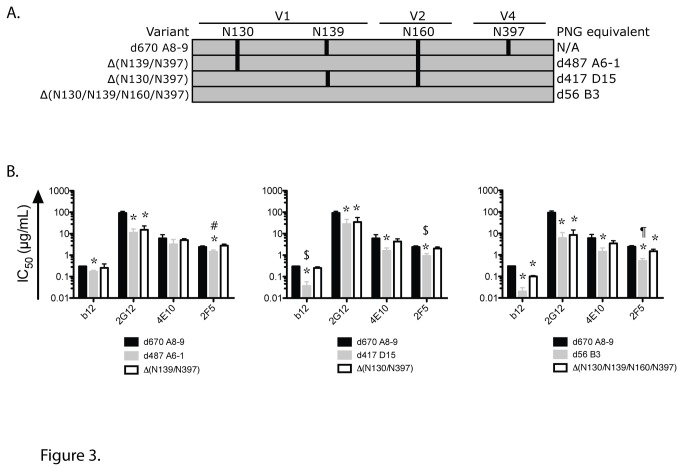
Specific PNGS affect heterologous neutralization.(A) Cartoon depicting PNGS profiles of A141 Env mutants. The mutants are indicated on the left and the corresponding PNG equivalent A141 clones are indicated on the right. Vertical bars indicate the presence of a PNGS at the amino acid positions (130, 139, 160 or 397) shown. (B) Serially diluted monoclonal antibodies (b12, 2G12, 4E10 and 2F5) were tested for the neutralization of the pseudovirus of interest [d56 B3, d417 D15, d487 A6-1 and d670 A8-9] or of the PNG mutant of interest [Δ(N130/397), Δ(N139/397) and Δ(N130/139/160/397)] in a TZM-bl cell assay. The MAb concentration (µg/mL) required to reach 50% neutralization of each pseudovirus is reported as IC50 (µg/mL). Data shown are mean +/- SD from three independent assays. P < 0.02 compared to d670 A8-9. #
P = 0.0003 compared to d487 A6-1. $
P ≤ 0.0006 compared to d417 D15. ¶
P = 0.0042 compared to d56 B3.